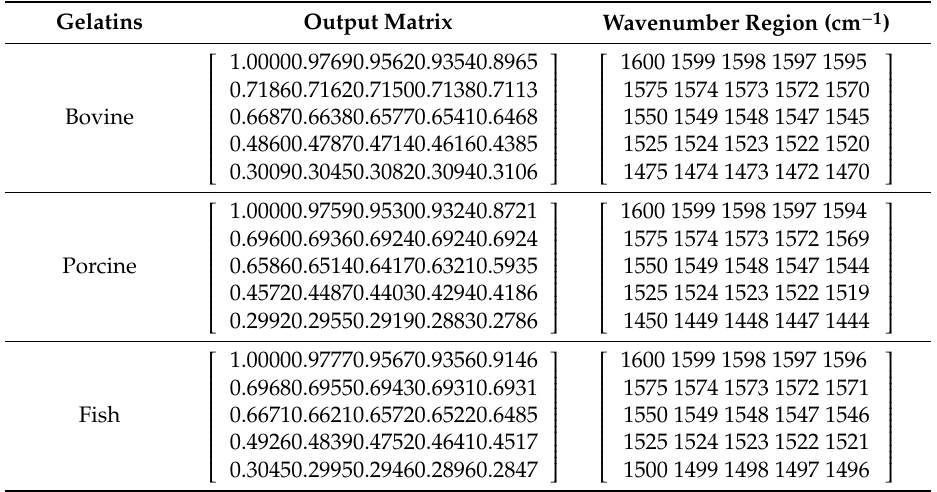
Table 1. Dominant matrices and their respective wavenumbers for bovine, porcine and fish gelatins.